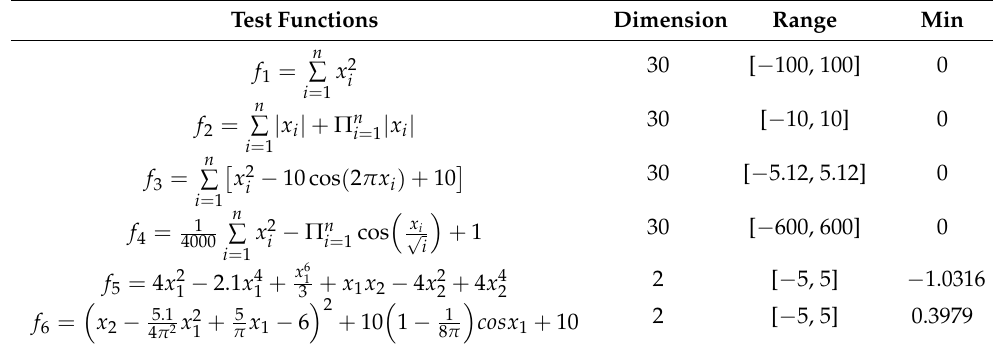
Table 2. Test functions. Test Functions